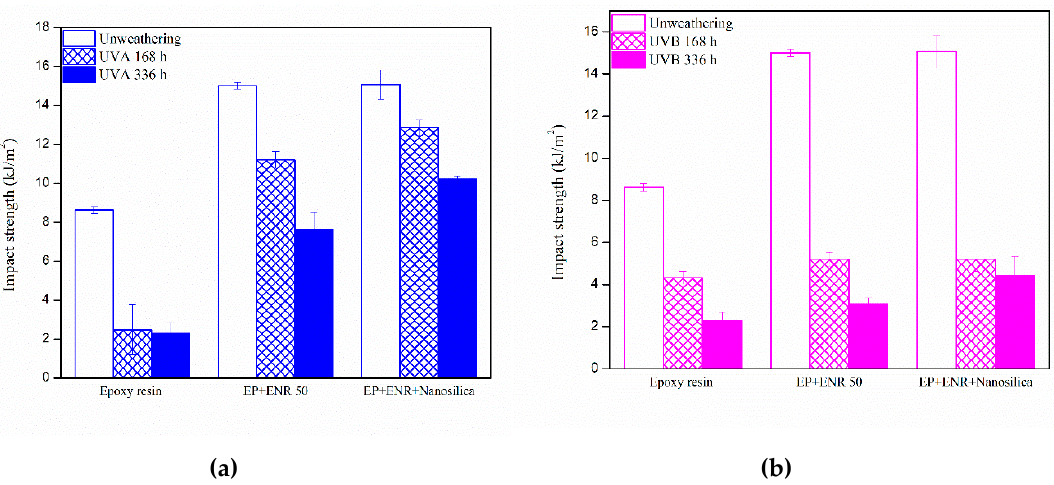
Figure 3. Impact strength of nanocomposites after accelerated aging ( a ) UVA and ( b ) UVB.